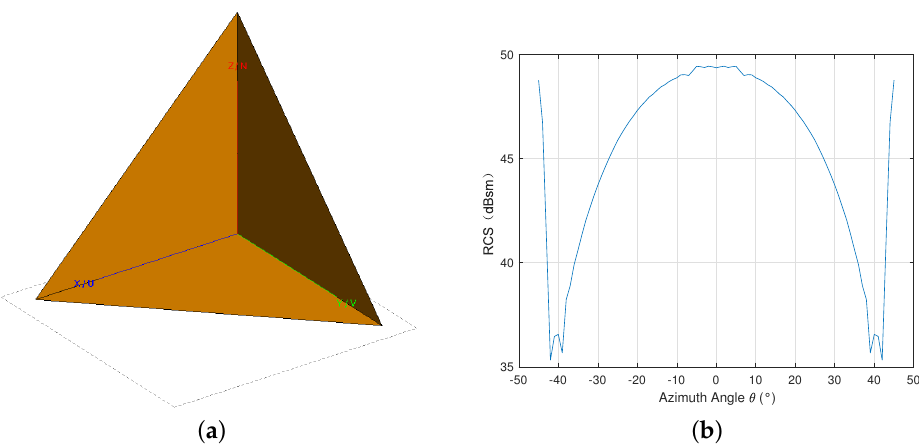
Figure 1. The scattering characteristic of the 9 m length TCR at P-band simulated with RL-GO.